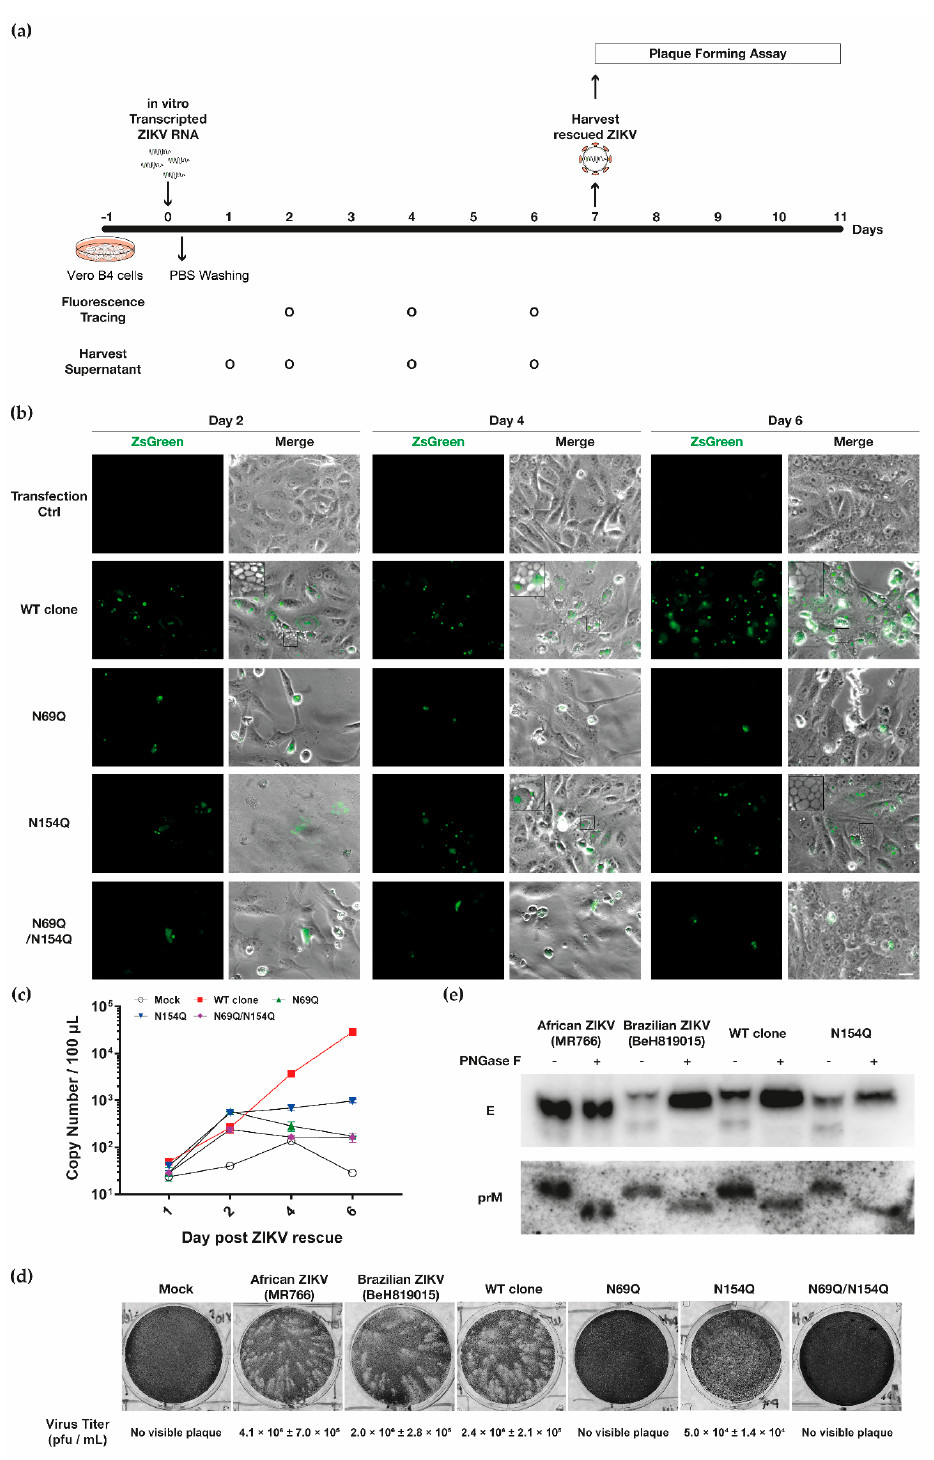
Figure 3. The N -glycan on ZIKV prM is important for the virus life cycle. ( a ) Schematic diagram of experiments. ( b )RepresentativepictureofZsGreenexpressionfromfourvariantsofZIKVRNAtransfected into Vero B4 cells. The monitoring was performed as scheduled in Figure 3 a . Scale bar = 20 µ m. ( c ) Virus egress kinetics by qRT-PCR, depicted as copy number of ZIKV NS5 RNA in 100 µ L of harvested supernatant, as scheduled in Figure 3 a . Mean values and standard deviations are shown from three independent experiments. ( d ) Representative picture of the plaque-forming ability of harvested